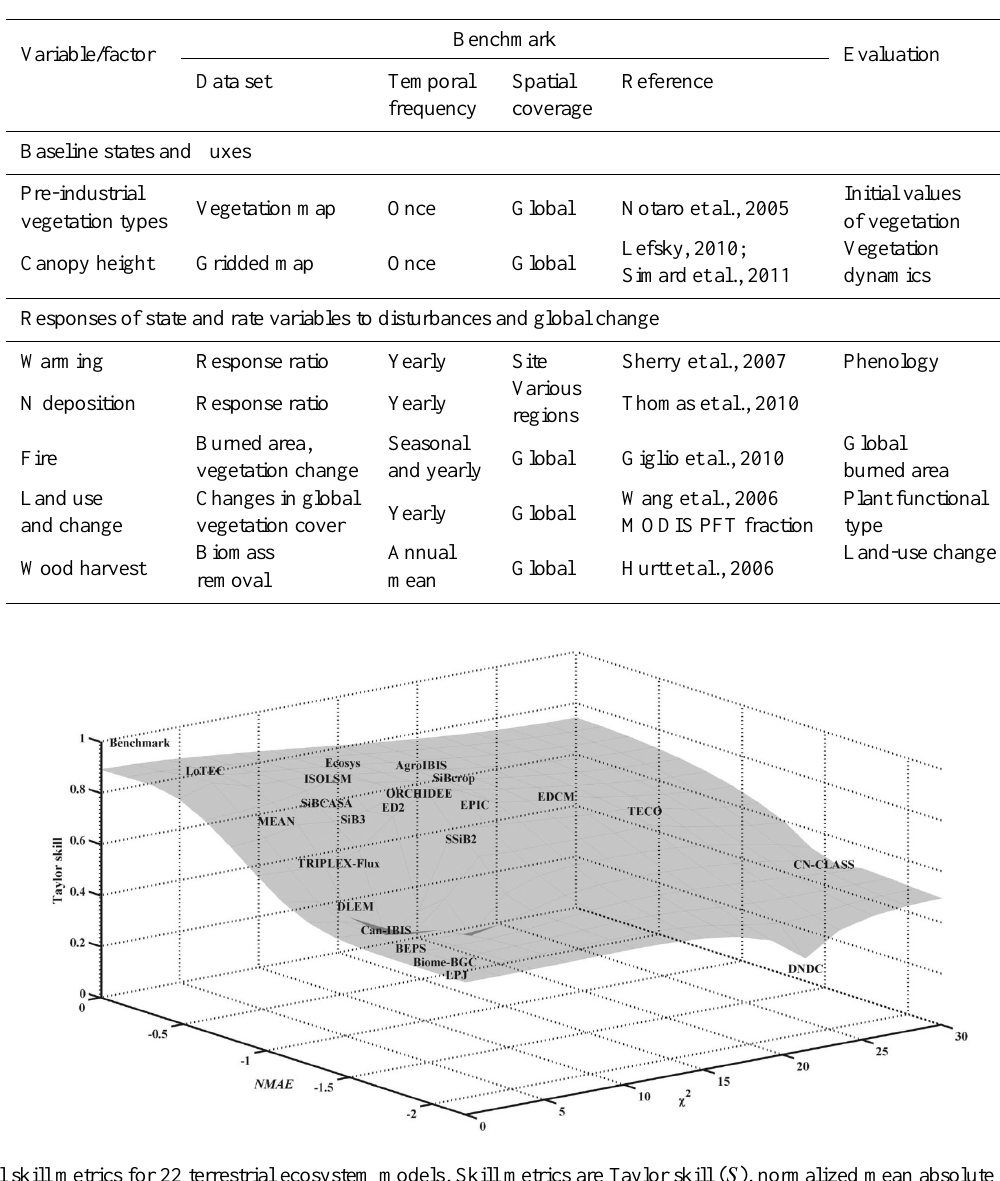
Table 4. Candidate benchmarks to be used to evaluate processes of vegetation dynamics.